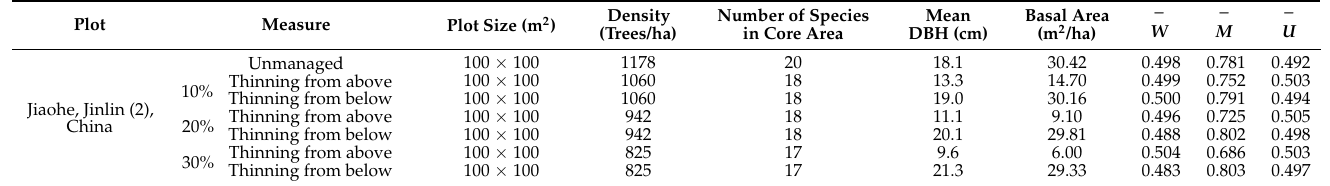
Table 4. Basic characteristics of six different simulated thinning plots in Jiaohe, Jinlin (2),